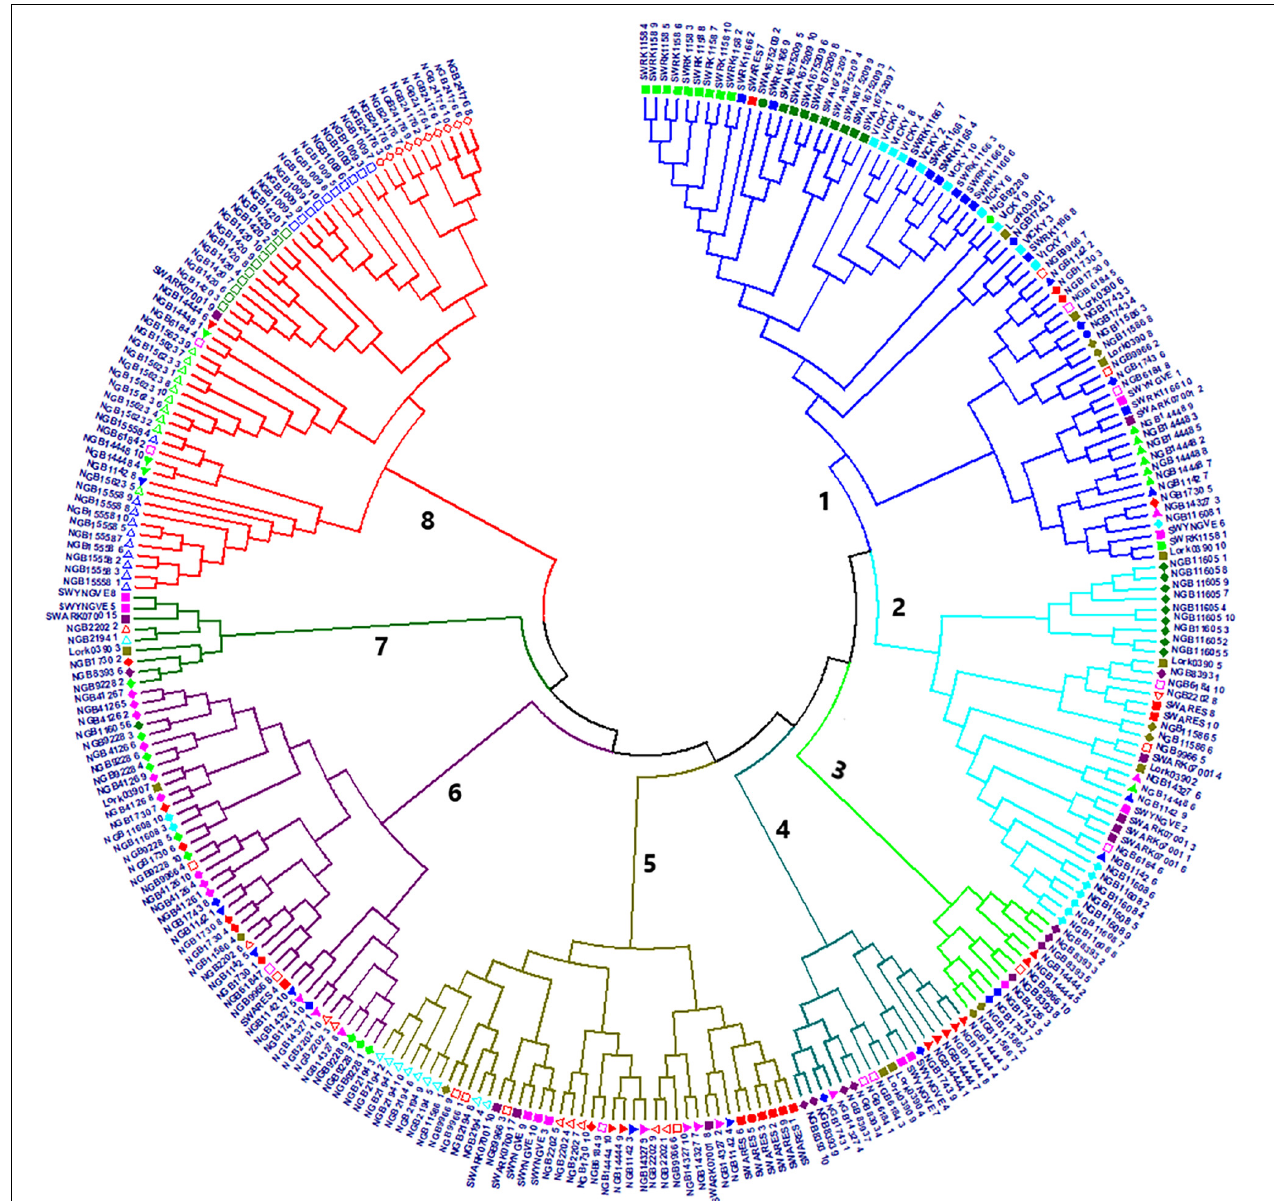
FIGURE 5 | A neighbor joining (NJ) tree of 288 individuals representing 29 accessions based on evolutionary distances computed by the Tamura-Nei method. Individuals sharing the same symbol and color belong to the same accession.